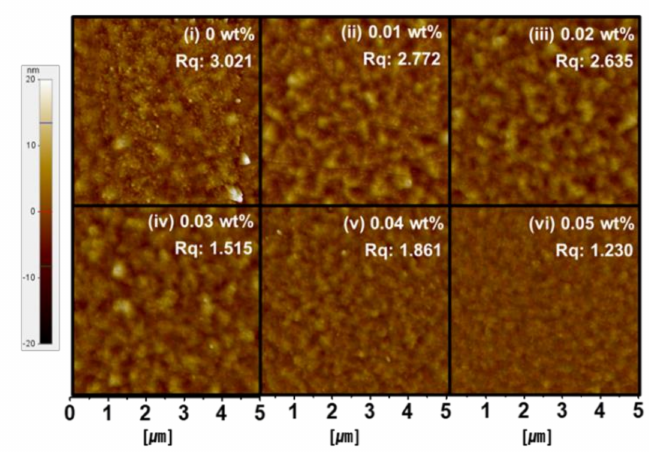
Figure 4. Dependency surface roughness of Ge 1 Sb 4 Te 5 film surface on ferric–ionic catalyst (i.e., PDTA–Fe) concentration after dipping of Ge 1 Sb 4 Te 5 film surface into slurries. The background AFM images estimated the presence of corrosion-induced pits and corrosion degree (i.e., Rq) on the Ge 1 Sb 4 Te 5 film surface after